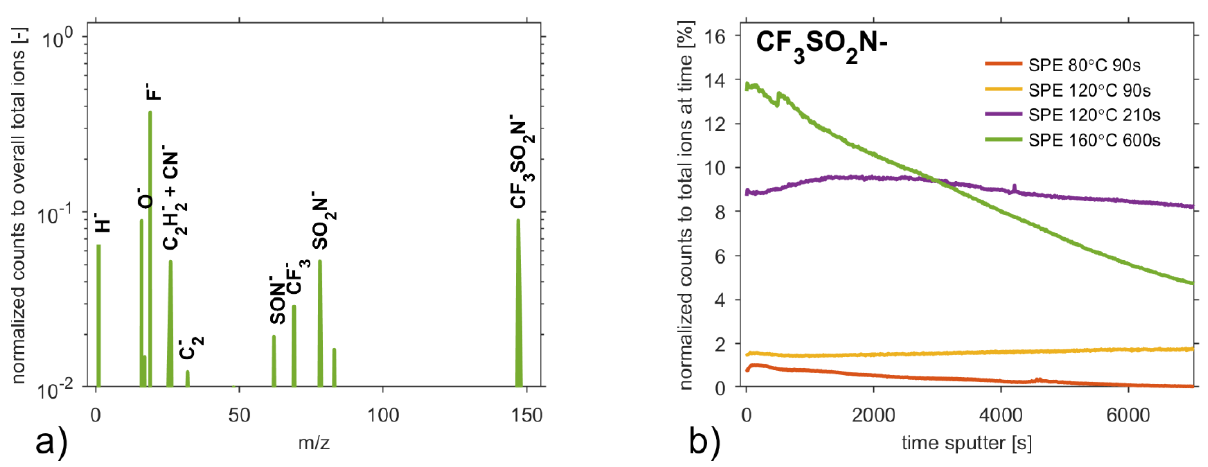
Figure 7. ( a ) Normalized negative ToF-SIMS spectrum taken from a SPE 160 ◦ C 600 s. Counts are normalized to the total sum of counts across the spectrum. Normalized intensities below 0.01 are ignored. ( b ) Normalized depth profiles of CF 3 SO 2 N − anion to total ions at the specific sputter time for all SPEs. Depth profiles are normalized with respect to the total count at specific sputter time. The spectrum and profiles are obtained by employing Cs + ions as a primary projectile with a kinetic energy of 2 keV.